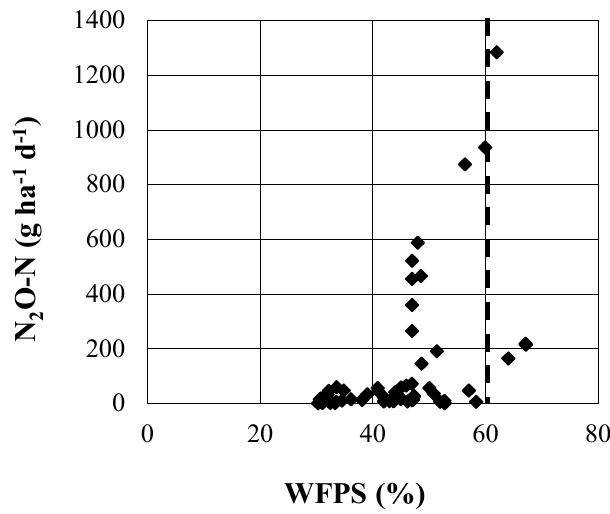
Figure 6. Daily WFPS (%) and the mean N 2 O-N emissions (g ha − 1 d − 1 ) across treatments measured in 2016 and in 2017. The dashed line represents the value of WFPS (i.e., 60%) below and above which N 2 O-N emissions are likely due to nitrification and denitrification, respectively.